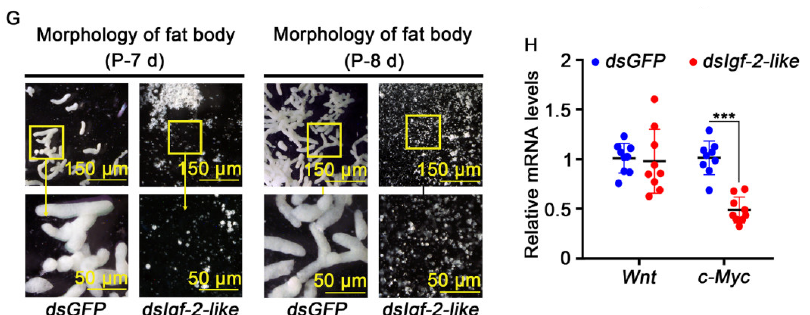
Figure 6. Knockdown Igf-2-like caused delayed pupation. ( A ) Detection of the knockdown efficiency of dsIgf-2-like by feeding the E. coli ; the off-target effect was detected by G-1-like . ( B ) The fat body protein was extracted at 6th-126 h to detect the knockdown efficiency after Igf-2-like knockdown by injection of dsRNA. β-ACTB was used as an internal reference protein. Image J was used to calculate the ratio of IGF-2-like and β-ACTB band densities. ( C ) The phenotype of larvae 144 h after feeding of dsIgf-2-like and dsGFP . ( D ) Statistical analysis of the phenotype. The data for the phenotype ratio were collected in triplicate using thirty larvae each time by feeding the E. coli . The delayed pupation was defined as a pupation time longer than the average pupation time of the dsGFP (142 h) group by feeding the E. coli . ( E ) The pupation time by feeding the E. coli . ( F ) HE staining of the midgut after the injection of dsIgf-2-like and dsGFP for 48 h and 60 h. ( G ) Morphology of the fat body after the first injection for 10 d and 11 d by injection of dsRNA. ( H ) The expression levels of Wnt and c-Myc in the fat body were detected after Igf-2-like knockdown by injection of dsRNA. All the experiments comprised three biological repetitions. The error bar indicates the mean ± SD, and a t -test was used to show significant differences (* p < 0.05, *** p < 0.001).